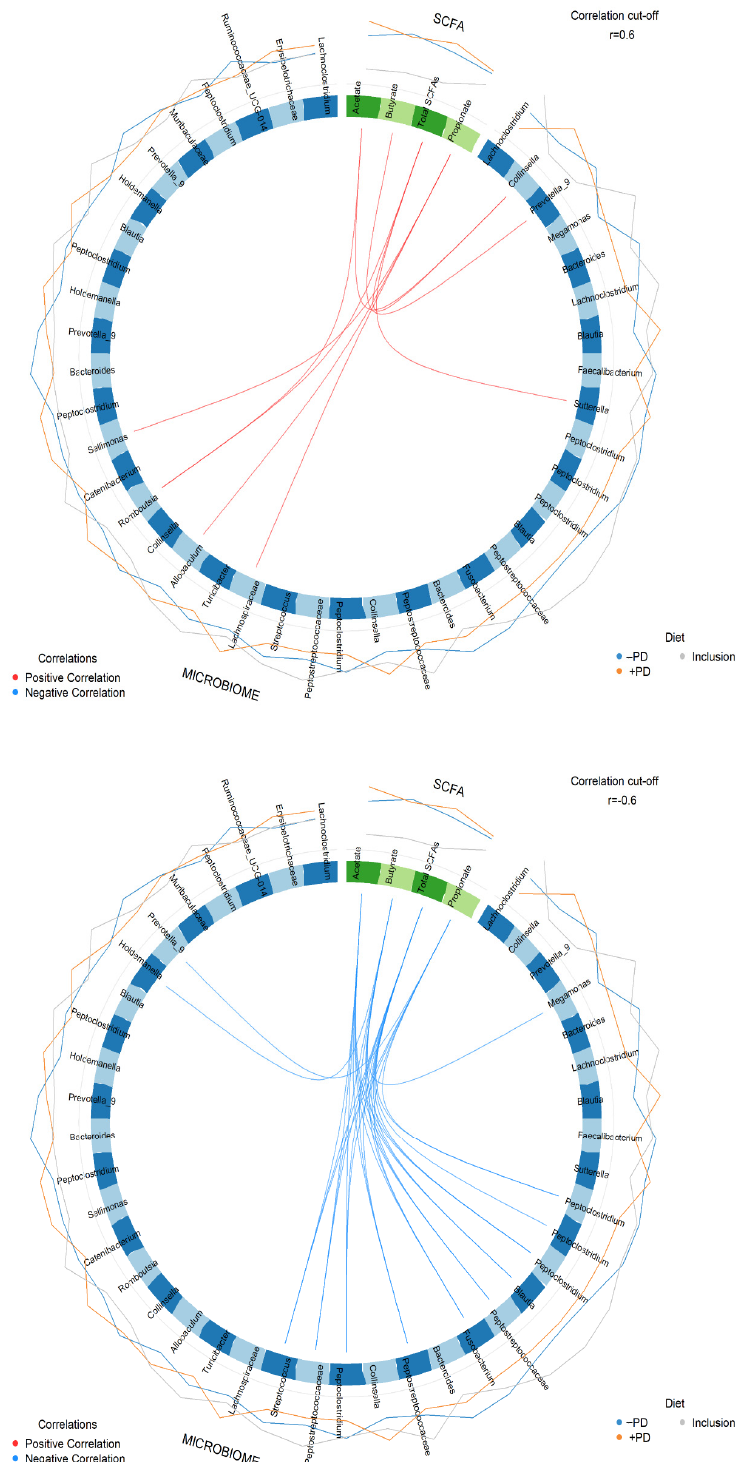
Figure 6. Correlation between microbial abundance and faecal acetate, propionate, butyrate and total short chain fatty acids concentration (SCFA). Circos plot illustrating positive correlations (r ≥ 0.6, connecting red lines) and negative correlations (r ≤ − 0.6, connecting blue lines) performed using multiblock sparse partial least squares discriminant analysis of faecal acetate, propionate, butyrate and total SCFAs, and relative abundance of faecal microbes at study inclusion (baseline samples, circumferential grey line), feeding a diet without ( − PD, circumferential blue line) or with 10 9 /kg Enterococcus faecium NCIMB 10415 (+PD, circumferential orange line).